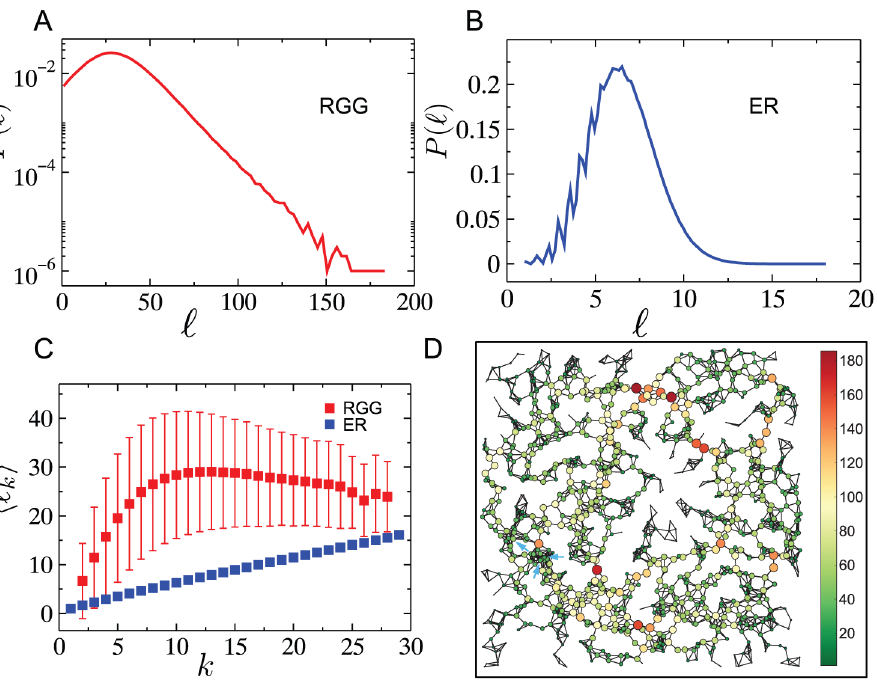
Figure 1. Vertex load profiles in RGGs and ER networks. Calculated on (A) random geometric graphs and (B) Erdo˝s-Re´nyi random grahs, composed of N ~ 1500 nodes with S k T ~ 10 and averaged over 2000 network realizations. (C) Positive correlations are shown in the case of ER graphs, while these correlations seem to disappear in RGGs for degree classes higher than the average degree of the network ensemble. Data were averaged over more than 3000 network realizations for networks of N ~ 1000 and S k T ~ 10 . The fluctuating tail of the red curve originates from the lack of sufficient number of samples in the specific degree classes. The error bars correspond to one standard deviations. (D) A single network realization ( N ~ 1000 , S k T ~ 6 ) showing the vertex loads. Note, that the node with the highest connections (blue arrows indicate the 3 highest degree nodes) does not carry the highest load in the network (loads are color coded, and node sizes are proportional to loads).